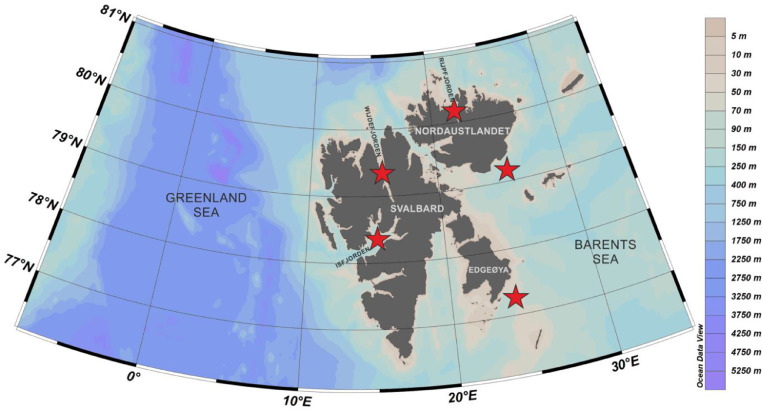
Study area and sampling localities.